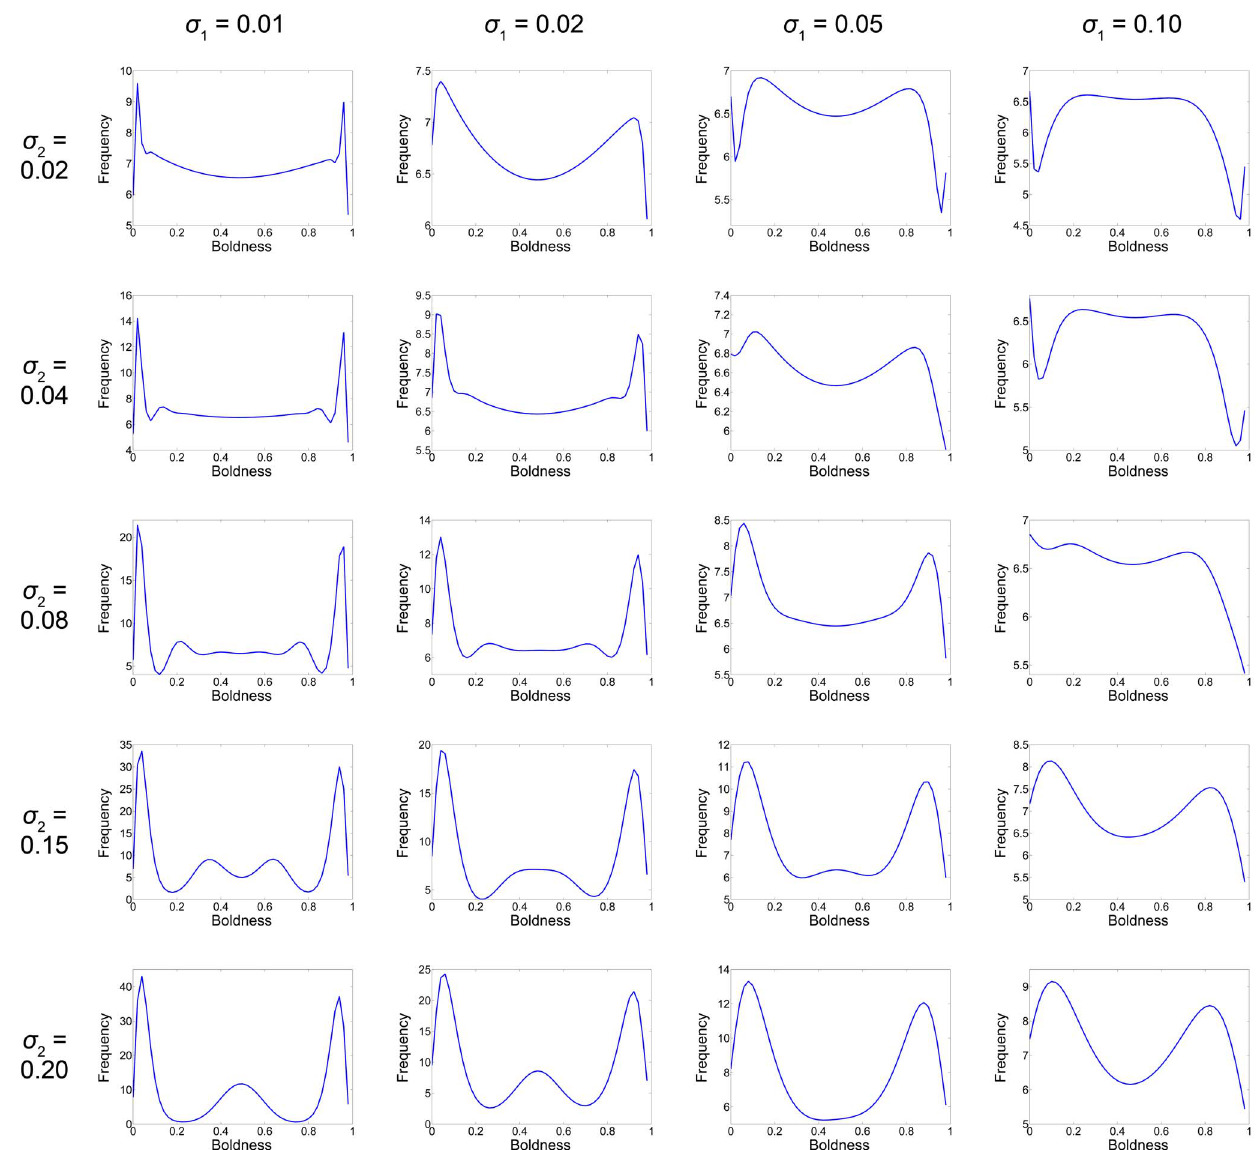
Figure 4. 2D Comparison of solutions with different s 1 and s 2 . The system was numerically simulated using an Upwind scheme until the solution reached an equilibrium state and then integrated along the age axis for simplification. Hence, frequency here is a measure of the total population of a certain boldness value. See also Figure 3.